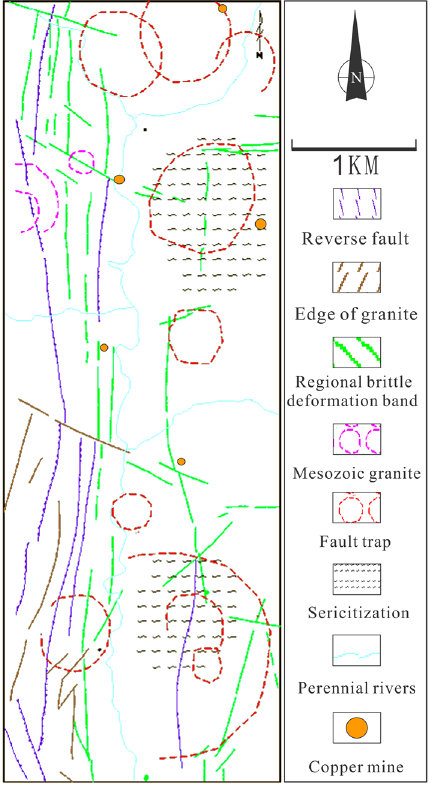
Figure 4. Remote sensing interpretation map.